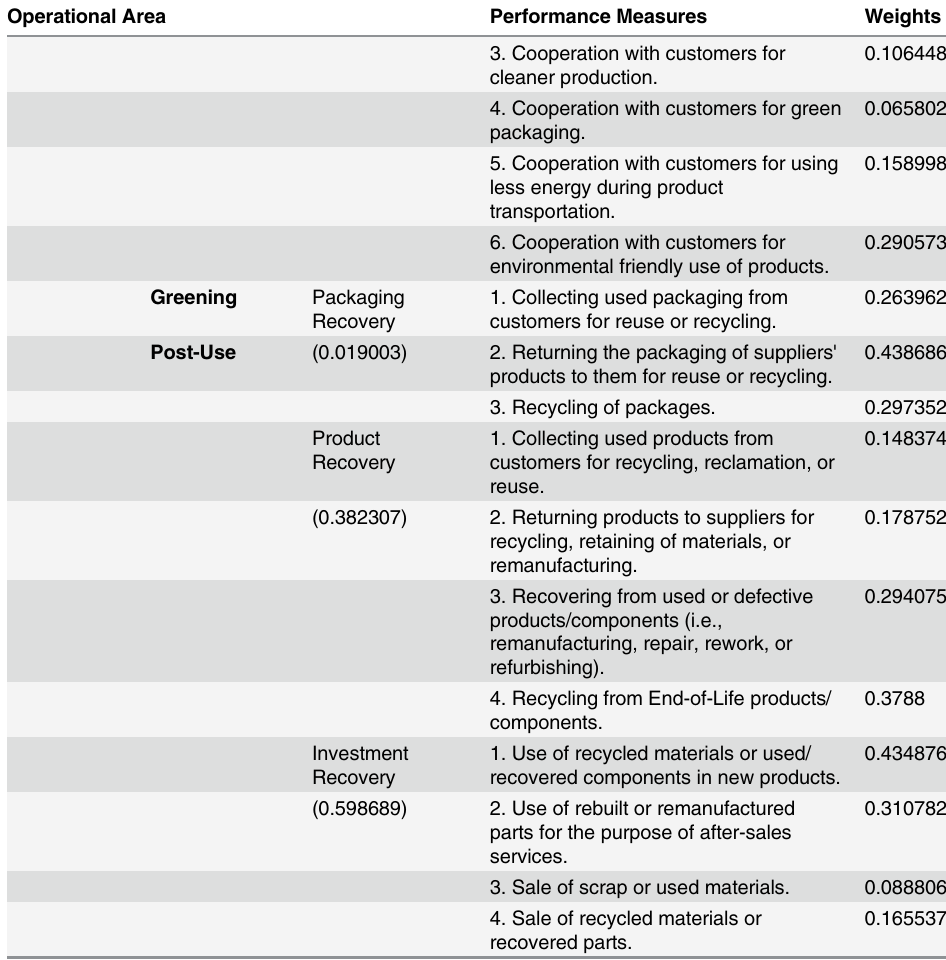
“ opportunity for improvement ” for each indicator with its relative weights, presented in Table 11. The final list of prioritised green strategies, GSCIs, and the various practices in each initia- tive can help company X initiate its strategic plan for its environmental improvement program. For example because the two highest ranks are assigned to the area of green production and greening upstream, improving these areas can be a good start for improving the firm ’ s green supplier management. Given the high priority of greening upstream, the company is recom- mended to pay close attention to expanding the extent of environmental actions to its supplier. Communicating a shared vision among the firm ’ s suppliers toward the pollution prevention strategy as the first-ranked green strategy is suggested as the starting point. The prioritised list of practices in the area of greening upstream also can be considered a guideline for developing the detailed environmental assessment program for